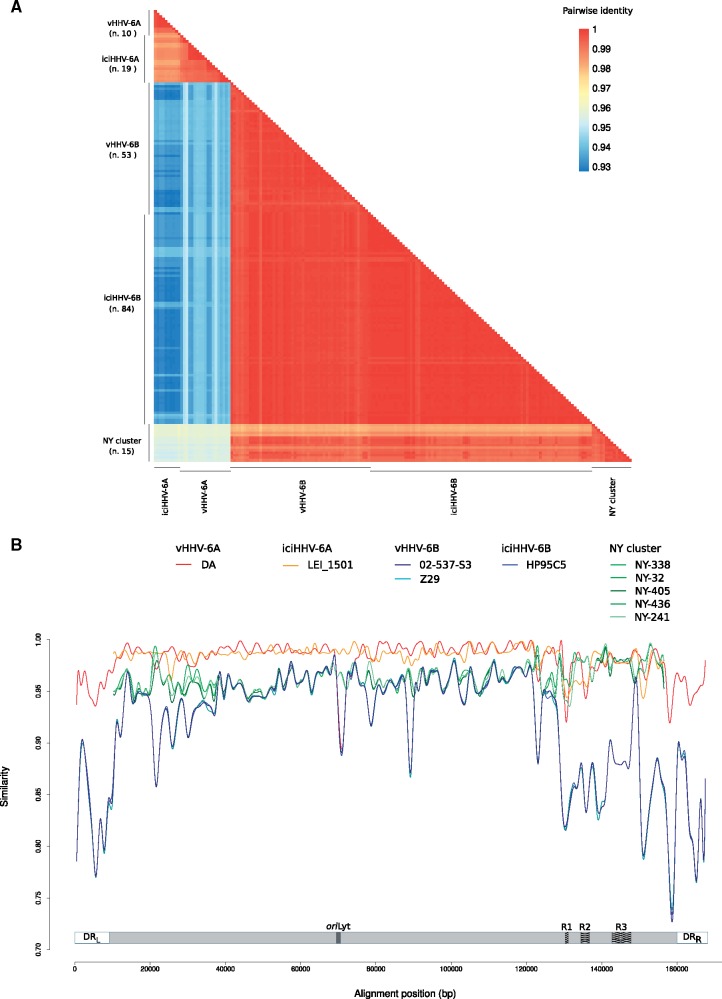
HHV-6 sequence identity. (A) Color-coded pairwise identity matrix generated from 181 HHV-6 genomes. Each cell represents the percentage identity score between two sequences (indicated horizontally and vertically). The legend indicates the correspondence between pairwise identities and the color code. Identity scores were computed over all positions where gaps are not observed in either sequence (see Section 2). iciHHV-6: inherited chromosomally integrated HHV-6; vHHV-6: exogenous HHV-6 viruses; the number of genomes (n) is also reported. (B) Similarity plot (generated with SimPlot) of representative NY cluster, HHV-6A, and HHV-6B genomes to the HHV-6A reference genome (U1102 strain). Each curve represents the comparison between a genome and the reference. Similarity (Kimura distance) was calculated within sliding windows of 1,000 bp moving with a step of 100 bp. The missing information for NY cluster viruses in the 5′ and 3′ genome regions is due to poor coverage (partial genome sequencing). A schematic representation of the HHV-6 genome is also shown. The positions (relative to the genome alignment) of the left and right DRs, of the origin of replication (oriLyt), as well as of the intermediate repeats (R1, R2, and R3) are reported.